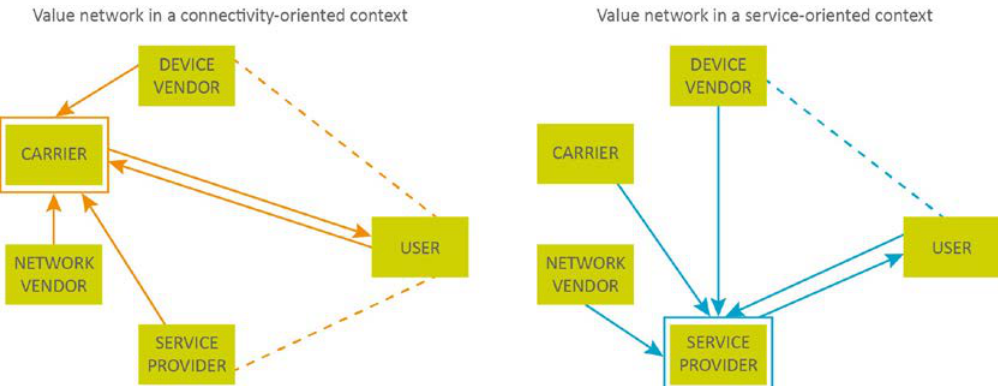
Figure 1 . In mobile broadband, the business is discussed in terms of connectivity; the most relevant actor corresponds to connectivity providers (carriers). In MTC the business is discussed in terms of the service that it is enabled on top of the con- nectivity, hence, the most relevant actor is the service